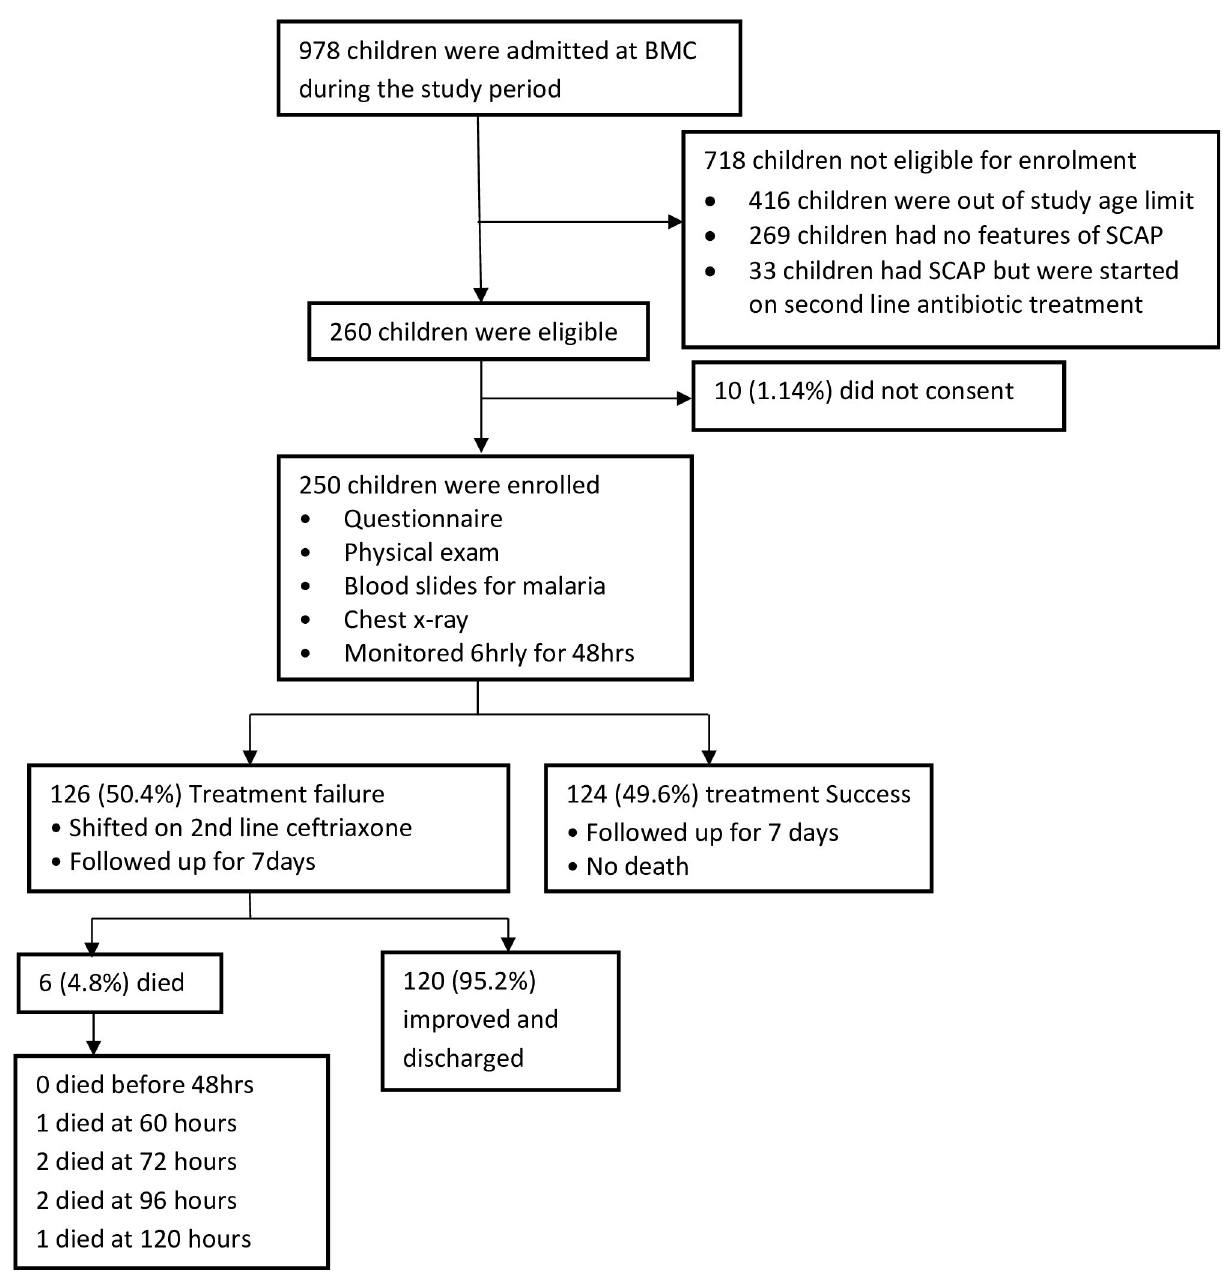
Fig 1. A flow diagram displaying participants’ enrolment and